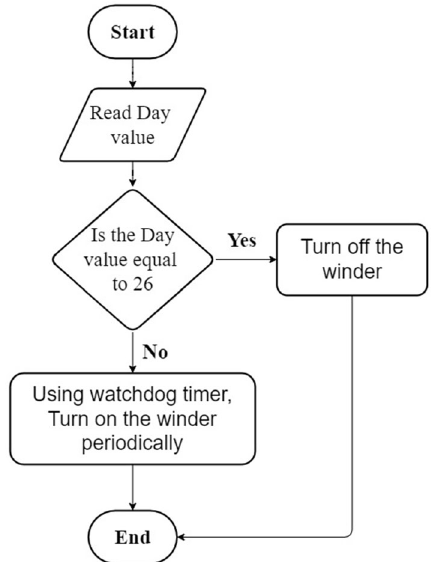
Fig. 3 Flowchart for fundamental decision making in the